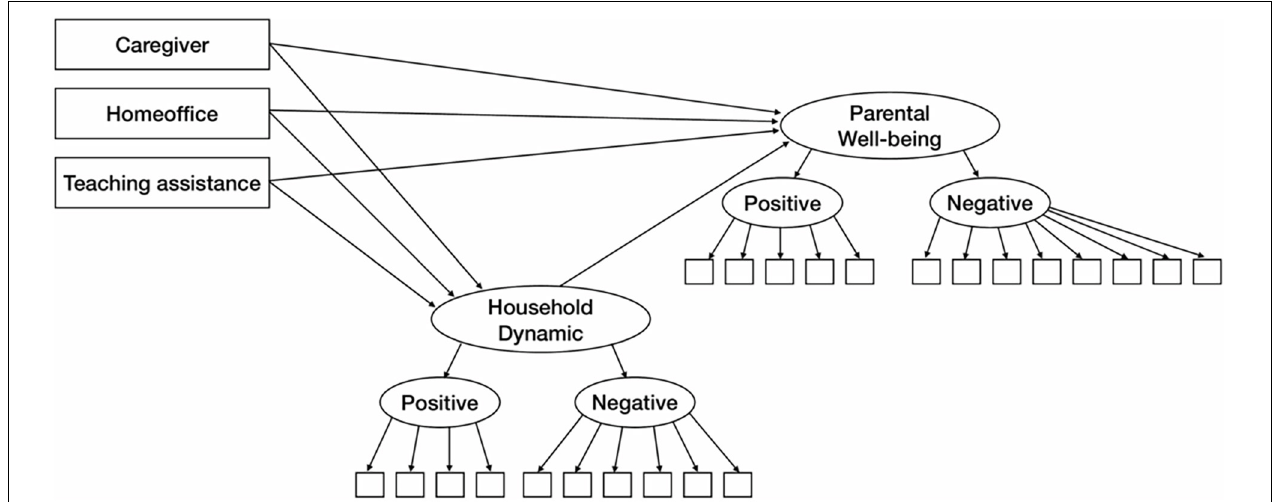
FIGURE 1 | Hypothesized model for partially latent structural